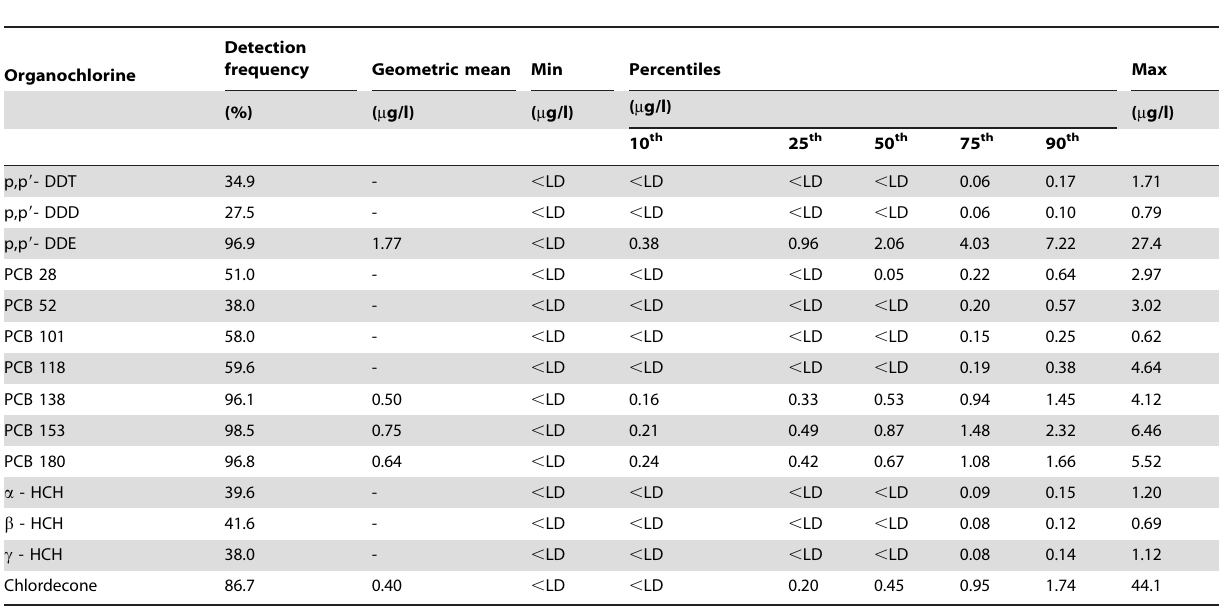
Table 2. Detection and concentrations ( m g/l) of persistent organochlorine pollutants in serum samples of the study population.